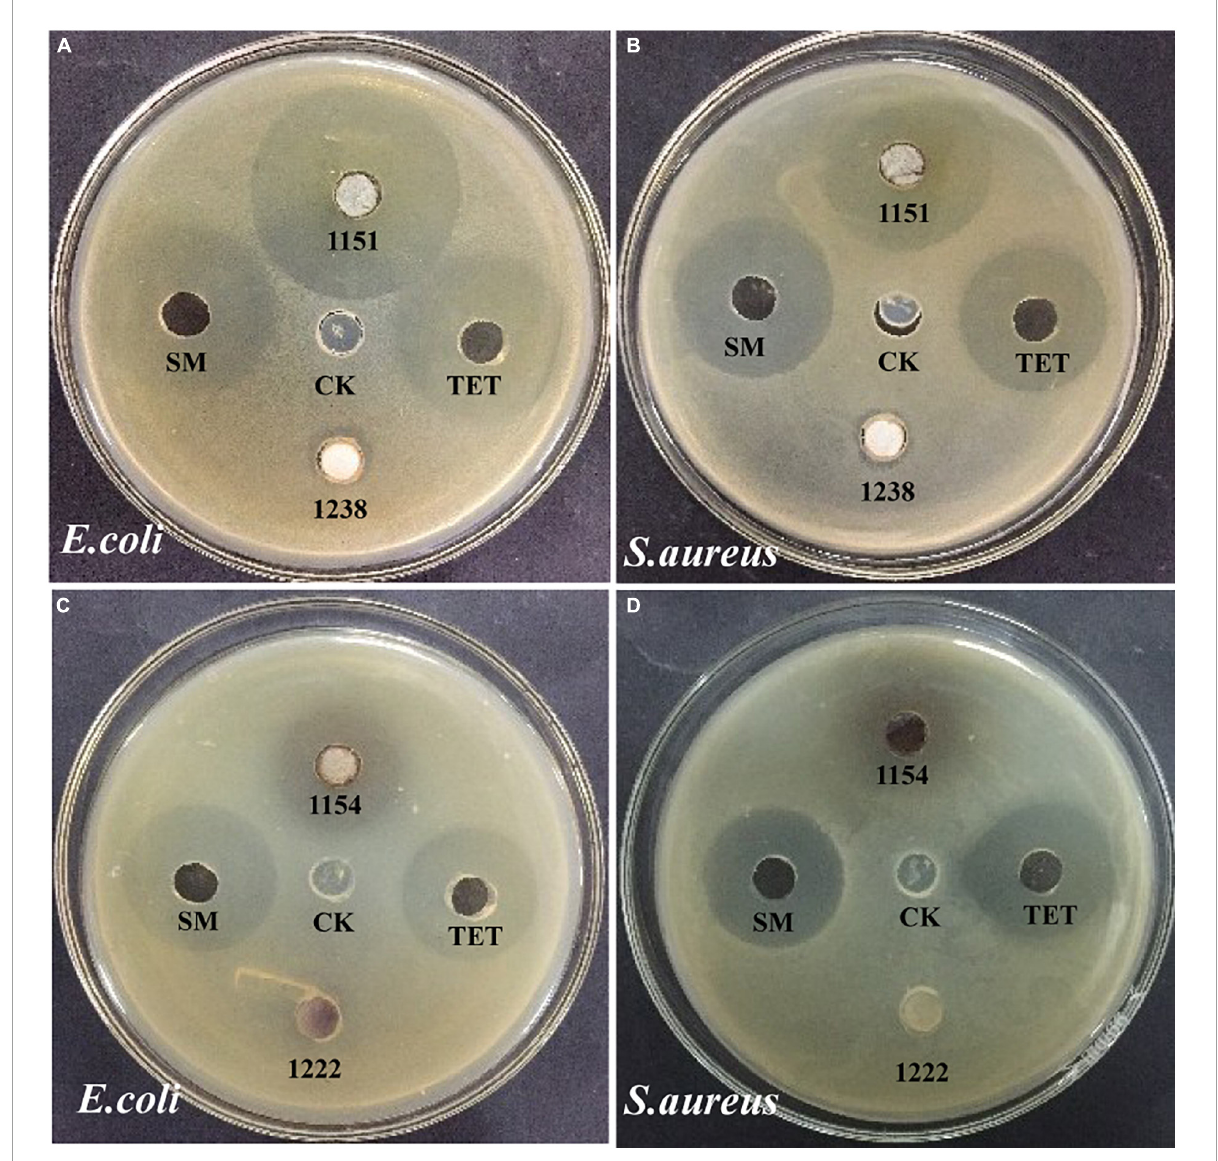
FIGURE3 Antimicrobial activity of the fungal endophyte agar plugs of Penicillium macrosclerotiorum 1151# and Epicoccum sorghinum 1154# against Escherichia coli (A,C) and Staphylococcus aureus (B,D) by agar well diffusion method. Dimethyl sulfoxide (DMSO) was used as the blank control (CK); Tetracycline (TET), and Streptomycin (SM) were used as positive control.